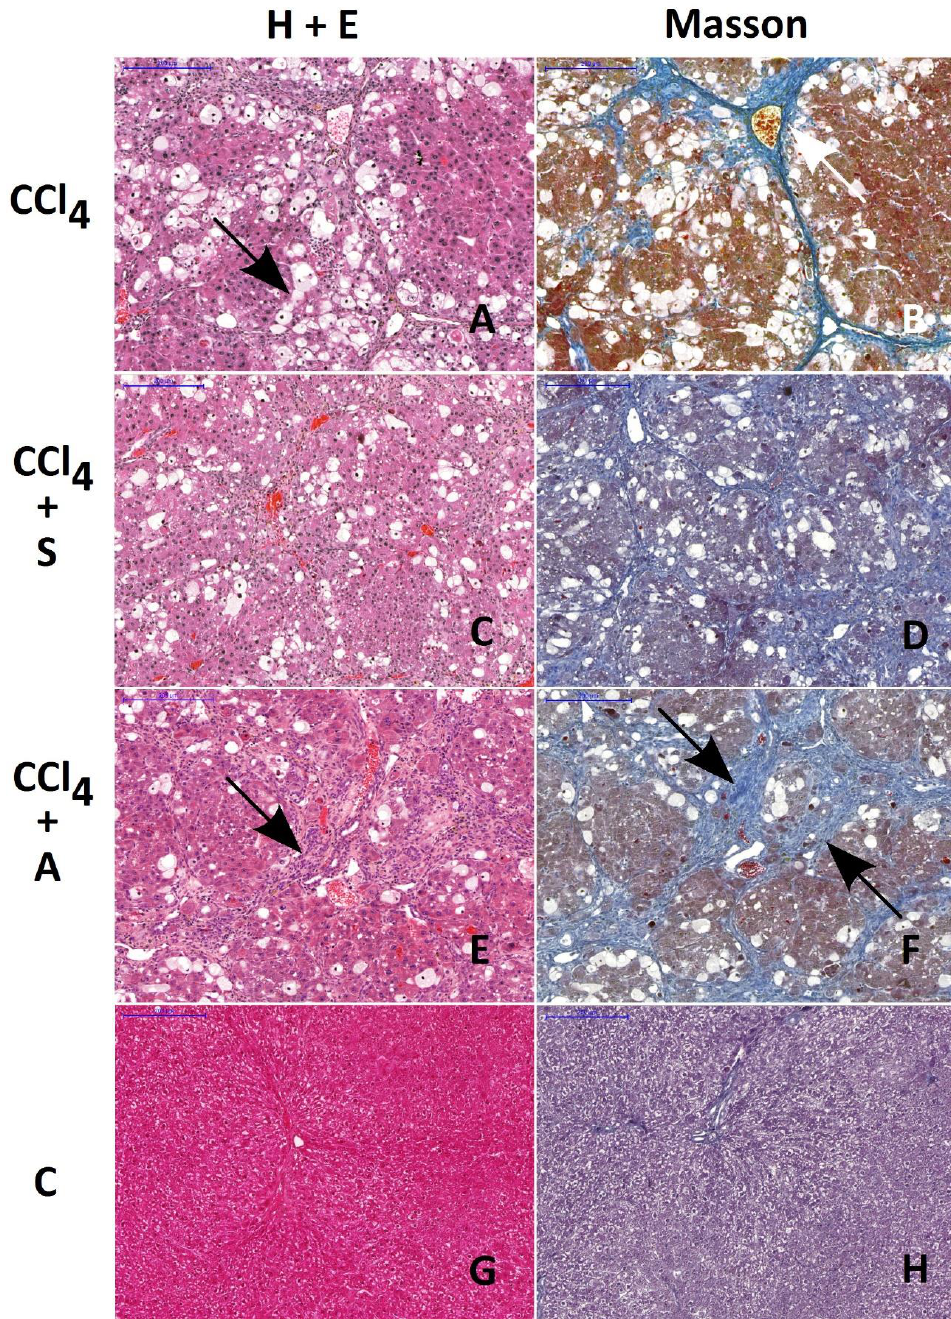
Figure 3. Histological evaluation of morphological changes in livers of rats treated with CCl 4 ( A and B ), CCl 4 + silymarin ( C and D ), and CCl 4 + chokeberry ( E and F ). Control livers are presented in figures ( G and H) . H&E and Masson staining. Note the similar extent of fibrosis in rats treated with CCl 4 and with CCl 4 + chokeberry (arrows on A , B , E , and F ). The number of vacuolated hepatocytes is significantly reduced in CCl 4 + chokeberry-treated rats ( E and F ) as compared to CCl 4 -treated animals. This alteration is accompanied by the increased expression of lymphocyte infiltration. Scale bar: 200 µm.